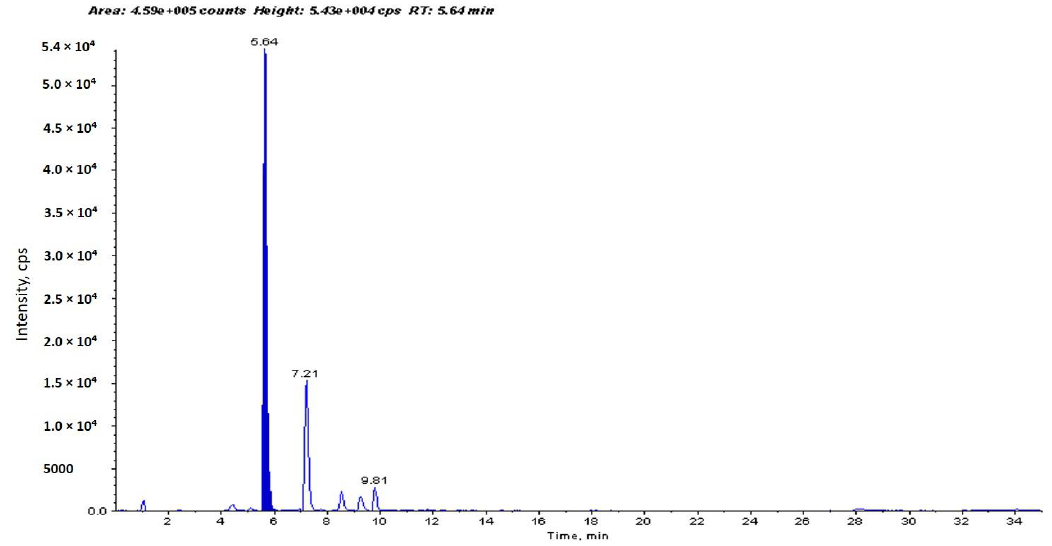
Figure 1. High-performance liquid chromatography-mass spectrometry (HPLC-MS) chromatogram of an aqueous extract of H. sabdariffa shows identification (two MRM transitions m / z 153 → 109 and m / z 153 → 91, at retention time 5.64 min) and determination of the concentration of protocatechuic acid (PCA). The other peaks are probably its isomers resulting from multiple reaction monitoring (MRM) transitions (at different retention times). PCA was determined to be 94.1 µg/g dry weight of Hibiscus calyces (0.0941%).